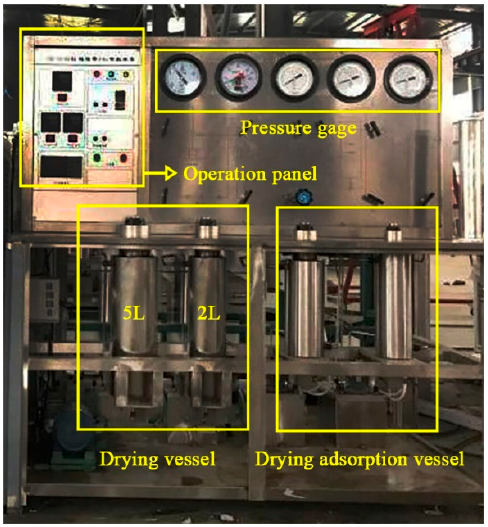
Figure 2. Supercritical CO 2 drying system.